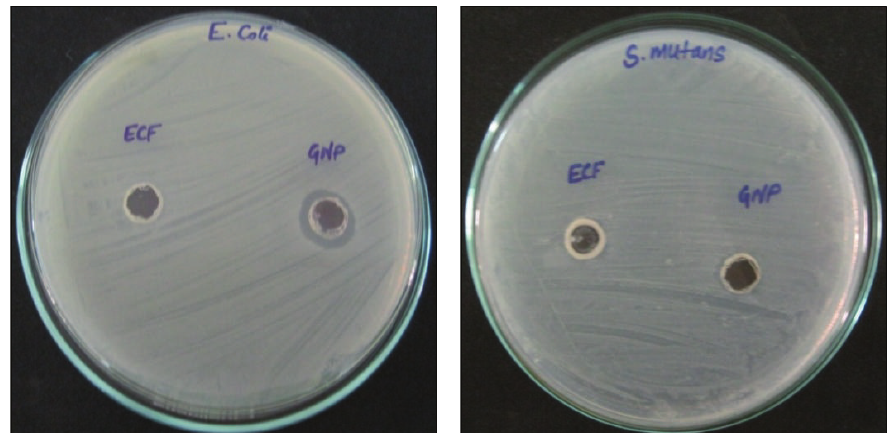
(b) Figure 9: Antibacterial activity of fungal ECF and biosynthesized GNP against different bacterial cultures: (a) Escherichia coli , (b)